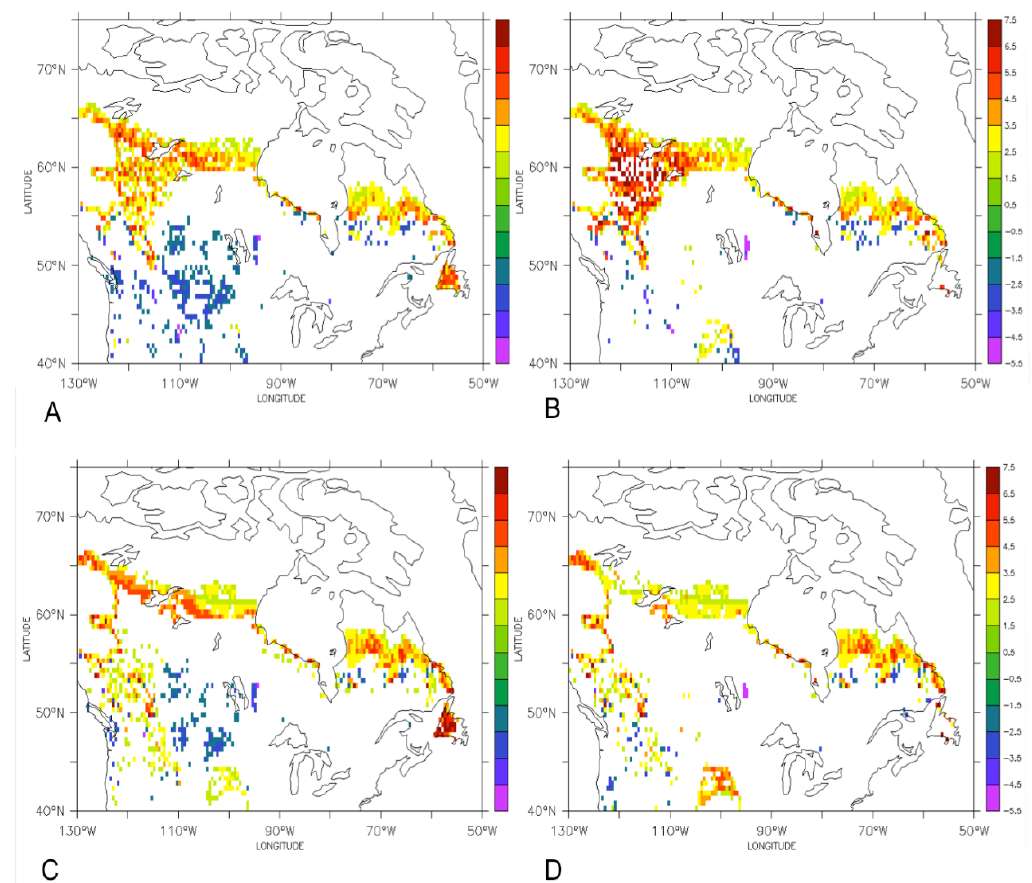
Figure 6. Map of the areas where the total biomass at the end of the transient simulation differs from that of the equilibrium simulation by ±2 Kg/m 2 for directed dispersal at ( A ) 1 km and ( C ) 10 km per year and the corresponding amounts, ( B ) and ( D ), that come from evergreen biomass. The deciduous PFT had not finished its expected migration in the 1 km simulation, so it still has a larger evergreen component (B increased biomass in the NW). Both simulations increased the northern extent of the forest as evergreen species migrated.